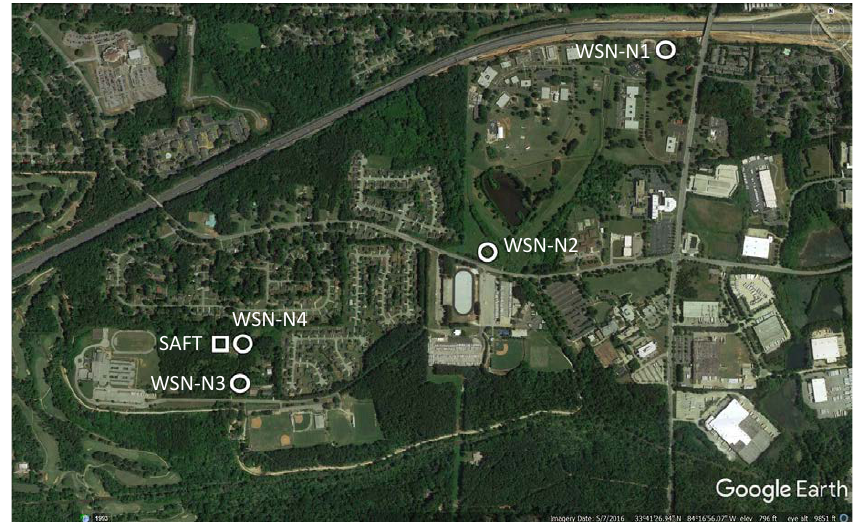
Figure 2. CAIRSENSE project wireless sensor network (WSN) and sensor ad hoc field testing (SAFT) locations. WSN-N4, SAFT, and the WSN communication base station are collocated with the NCore